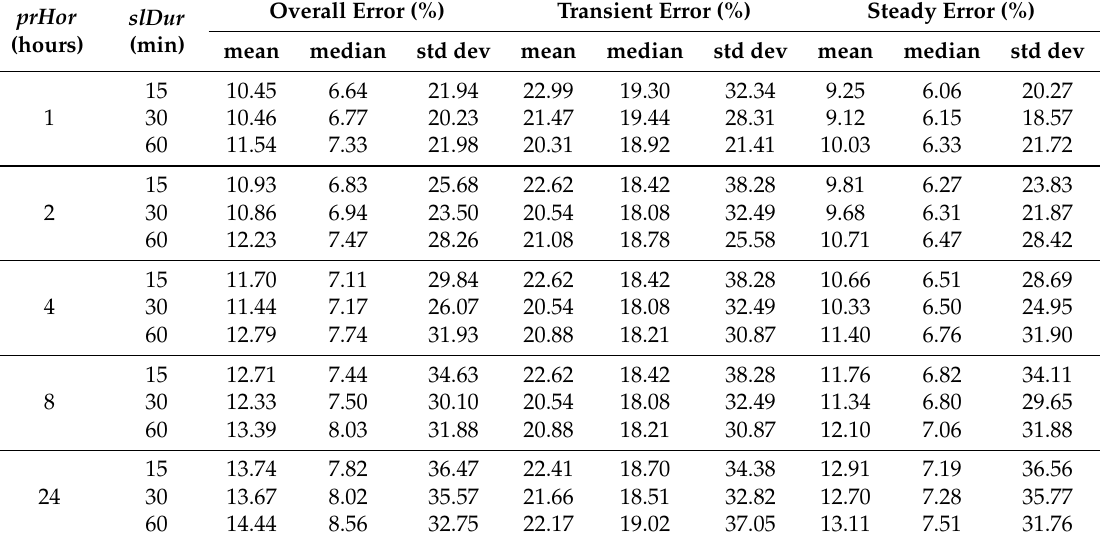
Table 4. Sensitivity analysis on slots duration .